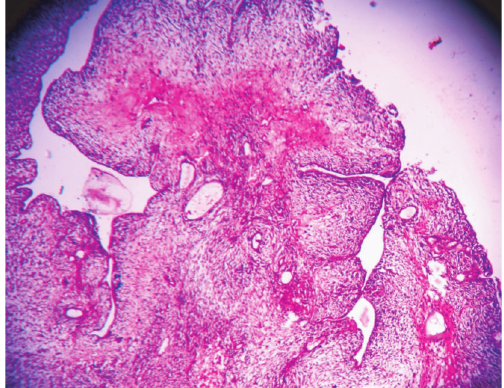
Figure 2: Photomicrograph showing phyllodes-like architecture on low power (H&E stain, × 100).